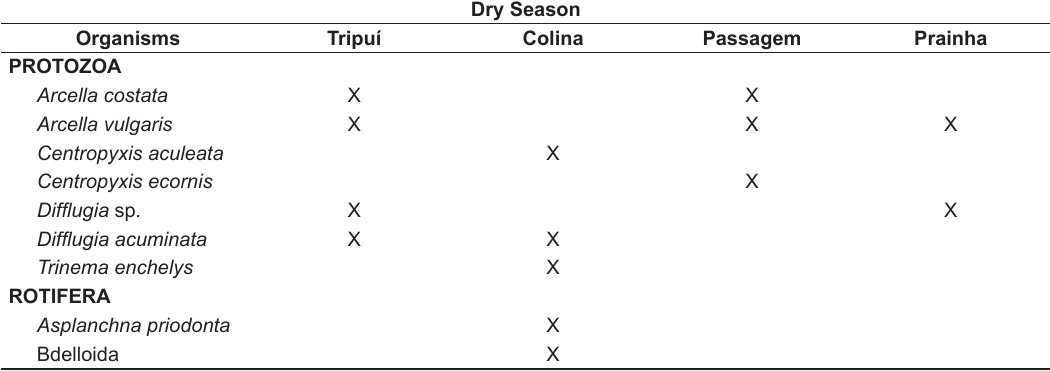
Figure 3. Linear regression for As and Cd concentrations in the studied area. Table 2. Presence of zooplanktonic species in the sampled points for the dry season.